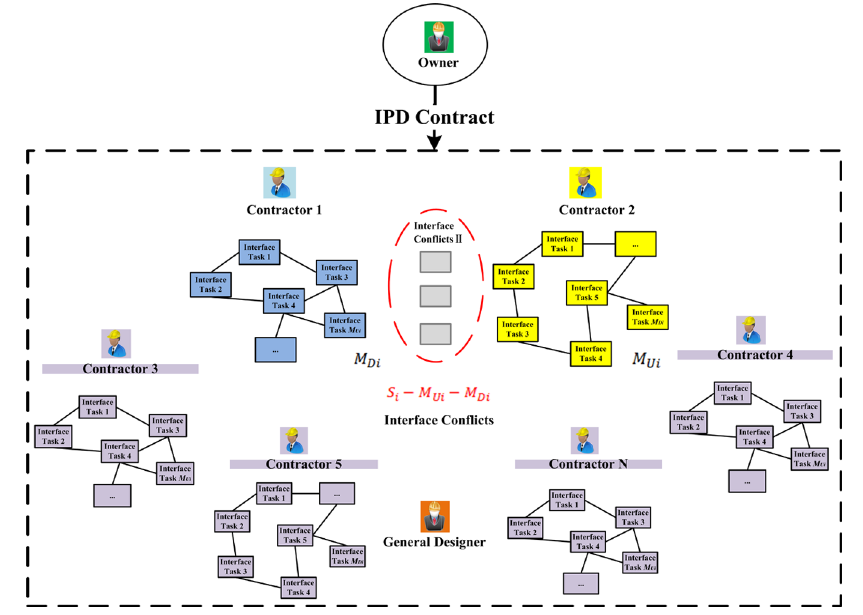
Fig. 4. IPD contract expected to eliminate interface